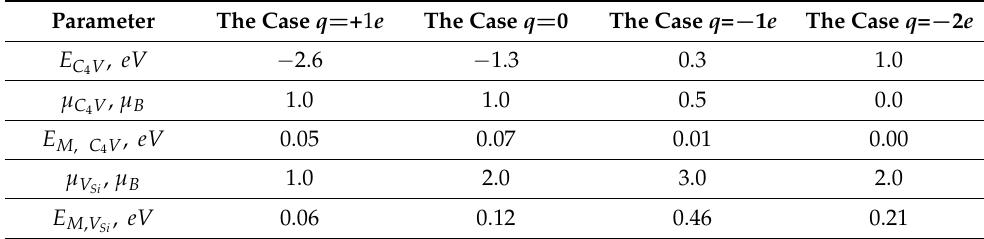
Table 1. Characteristics of the most favorable configurations of atoms at different values of vacancy charges q.